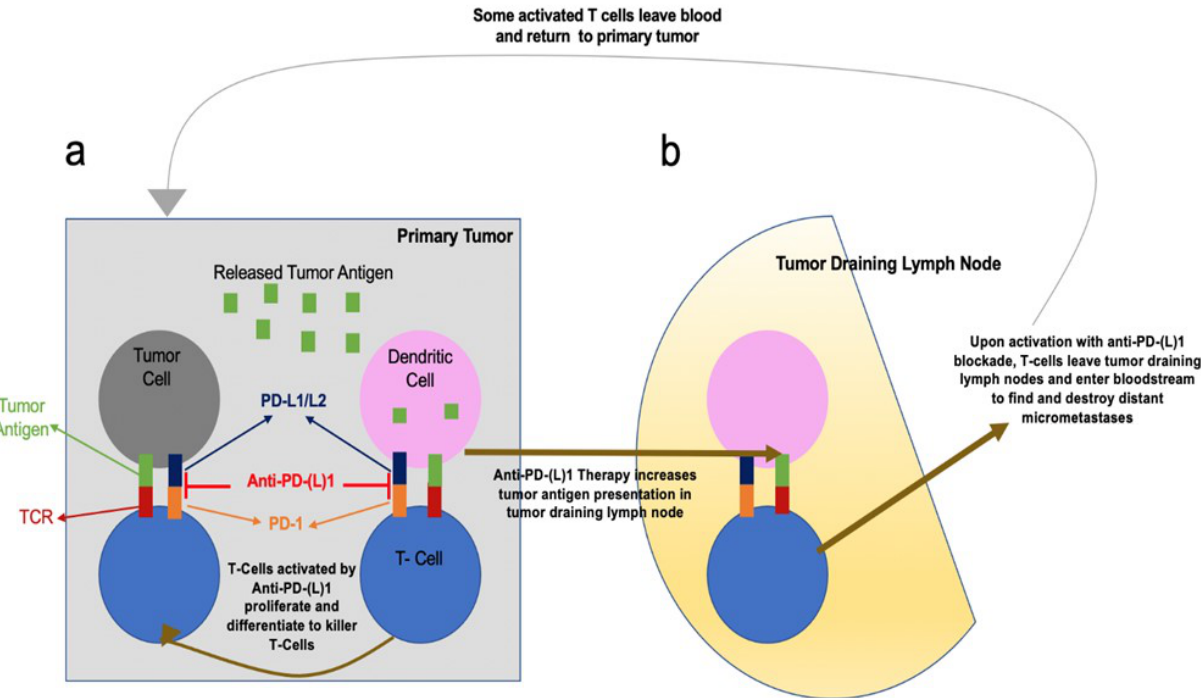
Figure 1. Main theories for enhanced systemic antitumor T-cell activity by neoadjuvant anti-PD-(L)1 Therapy. ( a ) Anti-PD-(L)1 therapy can stimulate and rejuvenate tumor-specific cytotoxic T cells residing in the tumor microenvironment. Thus, creating an in-situ expansion of tumor-specific T-cells by facilitating their activation, proliferation, and trafficking to micrometastatic deposits. ( b ) Anti-PD-(L)1 therapy can also improve stimulation of tumor-specific T cells by tumor antigen- presenting dendritic cells within tumor draining lymph nodes. From [18]. Reprinted with permission from